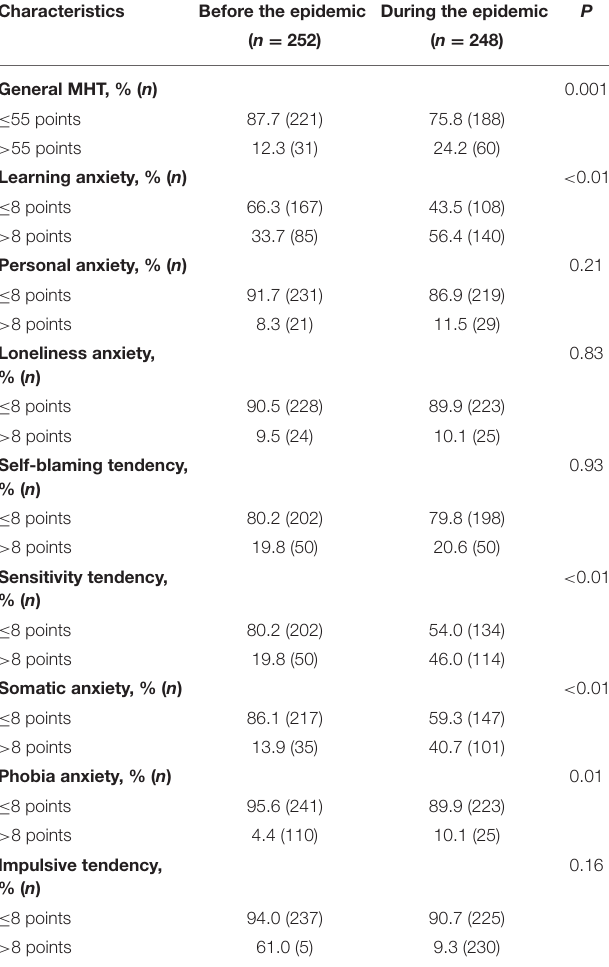
TABLE 1 | Psychological manifestations of adolescents before and during the COVID-19